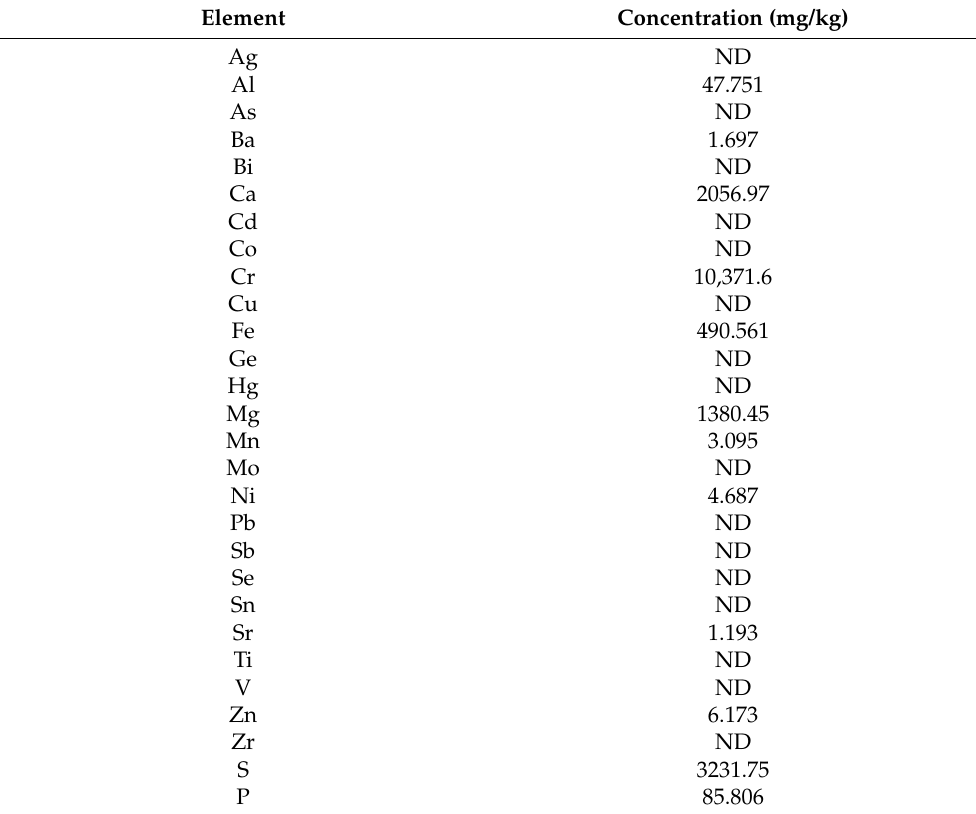
Table 2. Chemical composition of shavings—content of elements in a sample (mg/kg), ND—below the limit of detection. Element Concentration